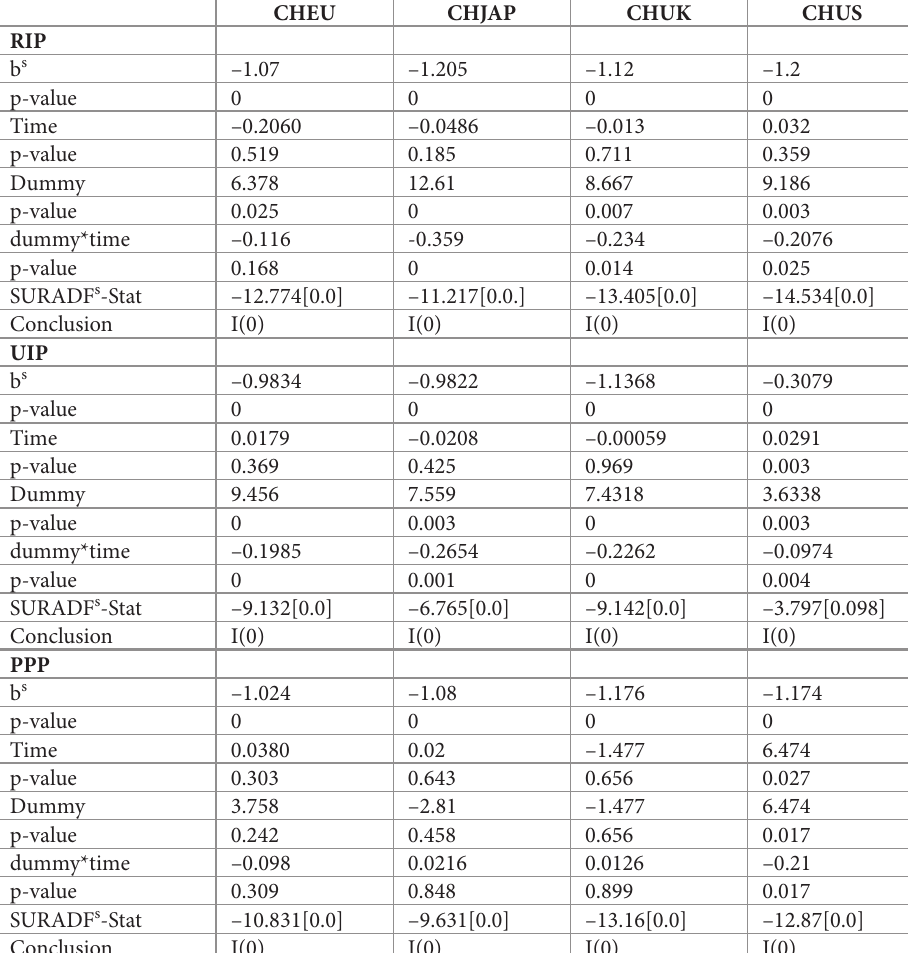
table 5. SUSADF test-parity conditions (structural break